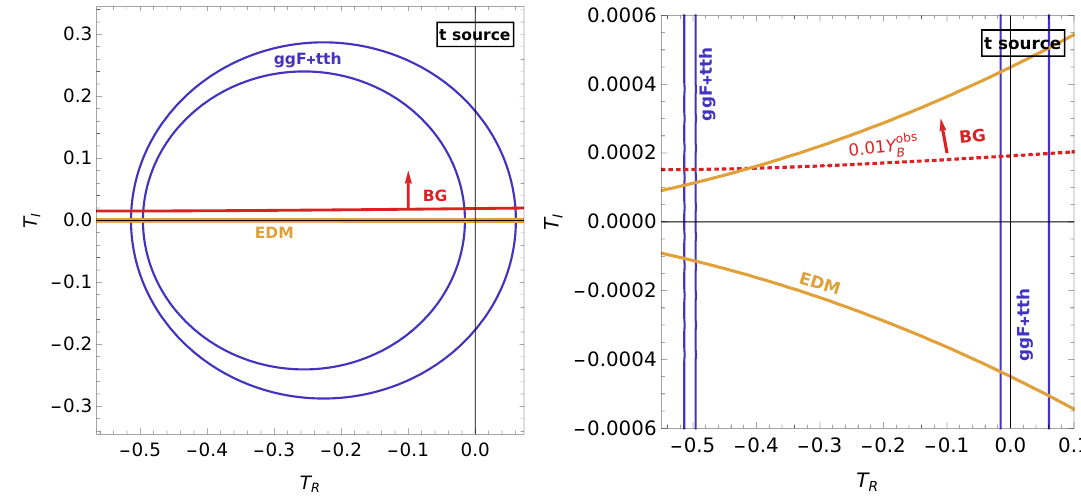
Figure 2 . Top source: constraints on ( T t and Y B (red). Left: full range of LHC bound, right: zoomed into range near EDM bound. The di(cid:11)erence in the scaling of Y B and d e in this case is due to the non-negligible contribution of the Yukawa interactions to the thermal mass of the